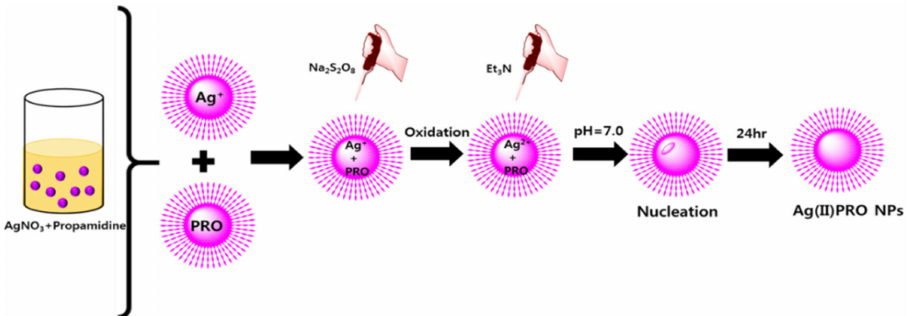
Figure 2. Schematic representation of the synthesis of silver(II) propamidine nanoparticles by reverse microemulsion